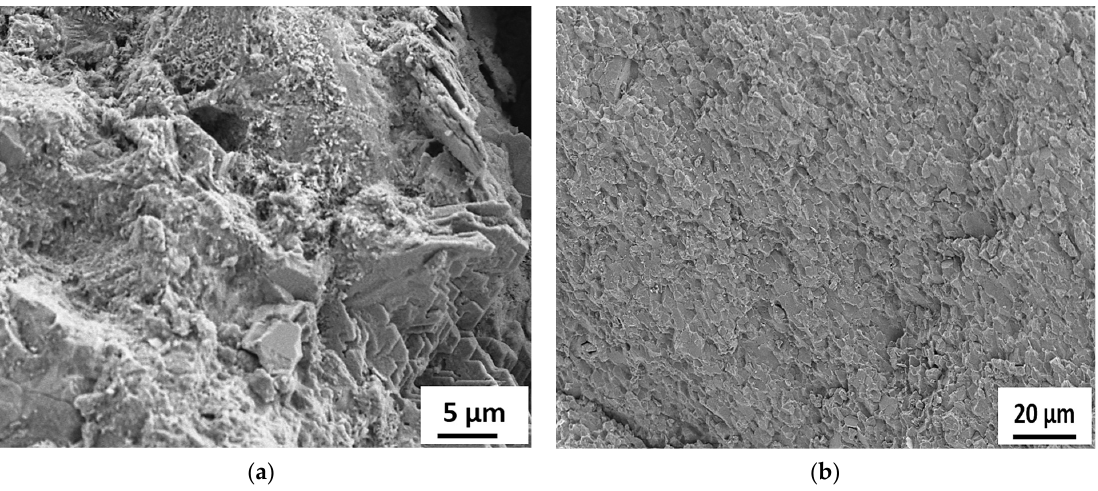
Figure 18. SEM images of specimens incorporating Shalozan aggregates ( a ) 20 µm (Mag. = 500×) ( b ) 50 µm (Mag. = 180×).